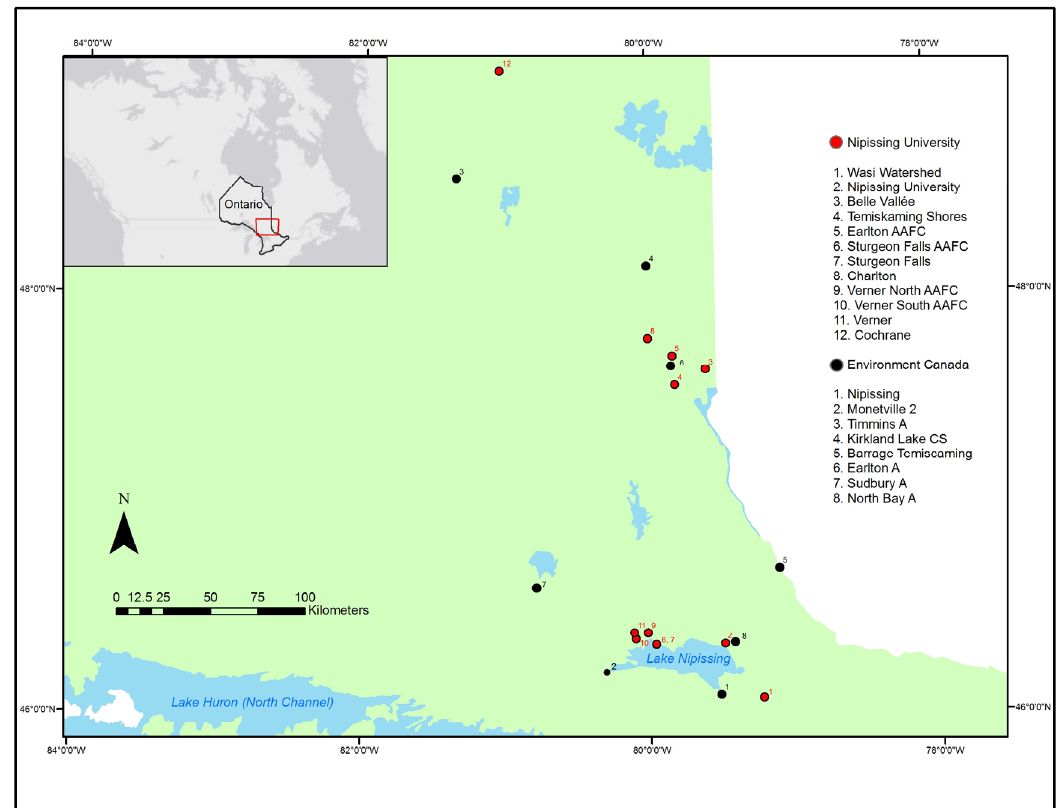
Figure 2. Location of current weather stations maintained by Nipissing University (NU) and by Environment Canada. NU stations numbered 1, 3, 4, 7, 8, 11, and 12 are currently fully integrated into GeoVisage .